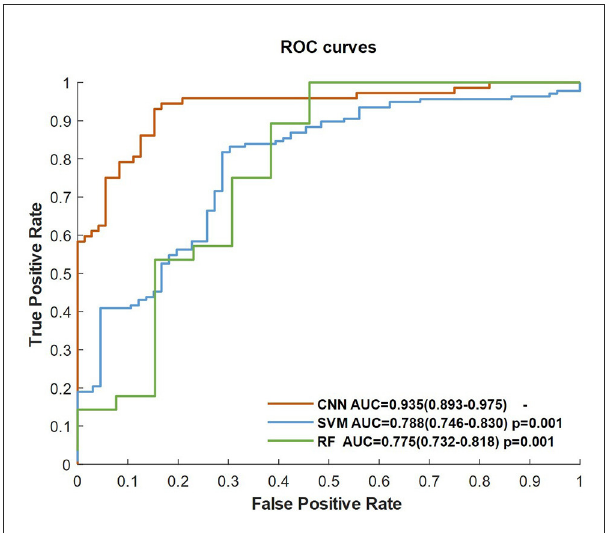
FIGURE2 ROC curves of the classifiers, including CNN, SVM, and RF.